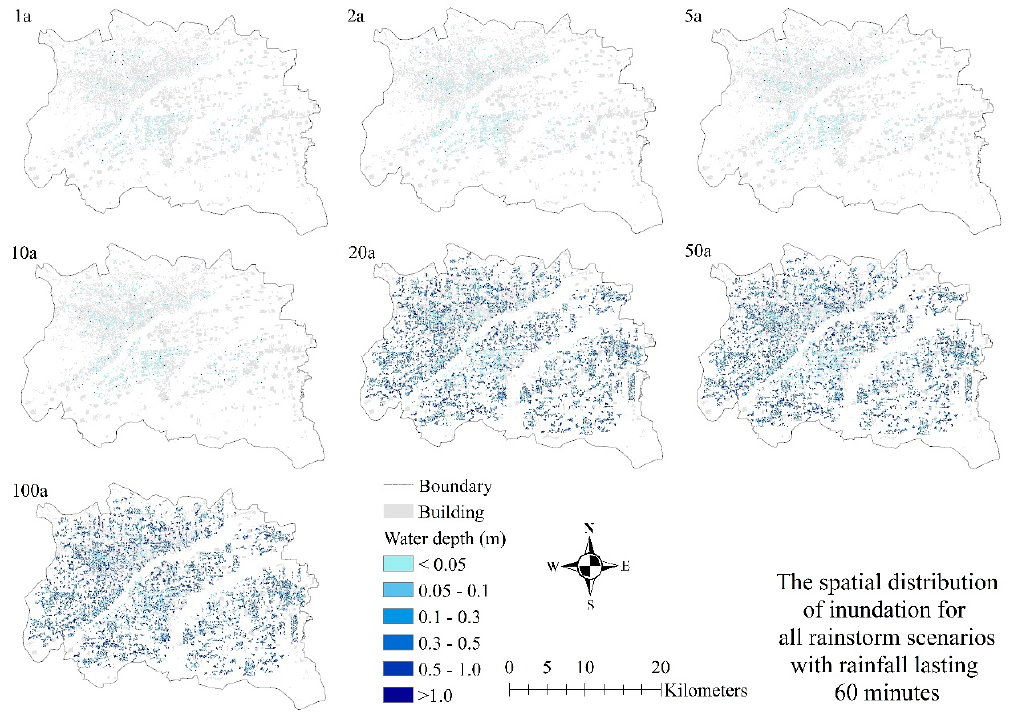
Figure 9. Spatial distributions of inundation for 60 min rainstorm scenarios.